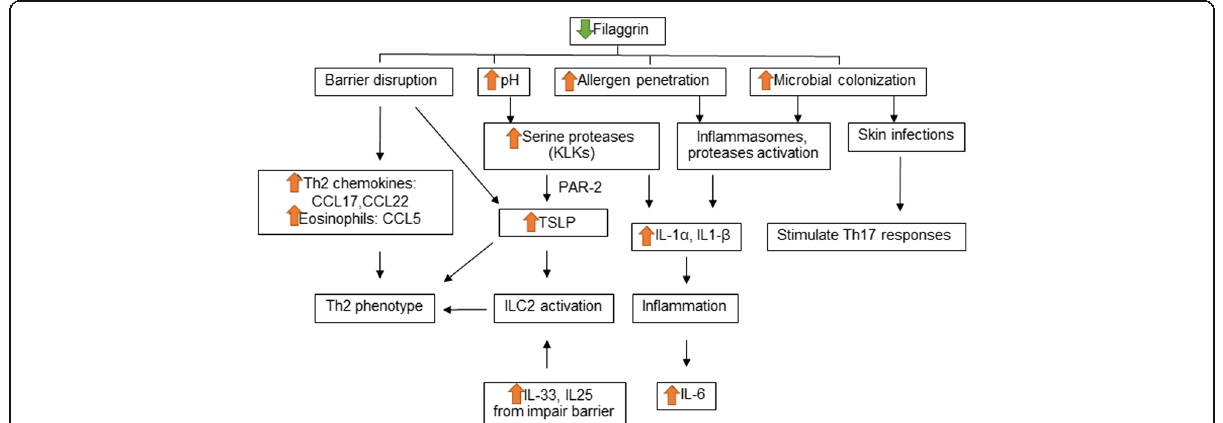
Fig. 1 Immunologic modulation of filaggrin (FLG) in the development of atopic dermatitis. Decreased FLG exacerbates skin inflammation in many ways. Th2 phenotype skewing occurs because of barrier disruption and keratinocyte injuries that stimulate thymic stromal lymphopoietin (TSLP), Th2, and eosinophil-recruiting chemokines together with IL-33 and IL-25 released from keratinocytes. Moreover, the loss of the acid mantle in the epidermis also promotes TSLP secretion via protease-activated receptor type 2 (PAR-2) activation by increased serine proteases. Enhanced allergen penetration and microbial colonization activate inflammasomes and the Th17 pathway that complicate the pathogenesis of AD in a later